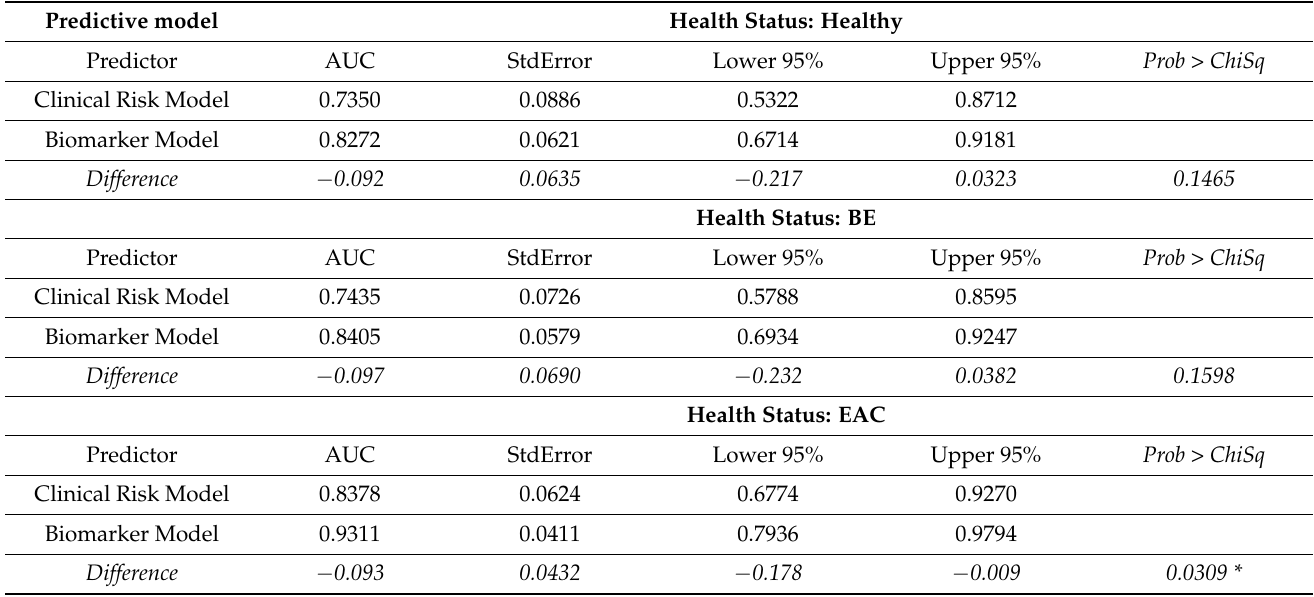
Table 2. Comparison of health status classification by each model.